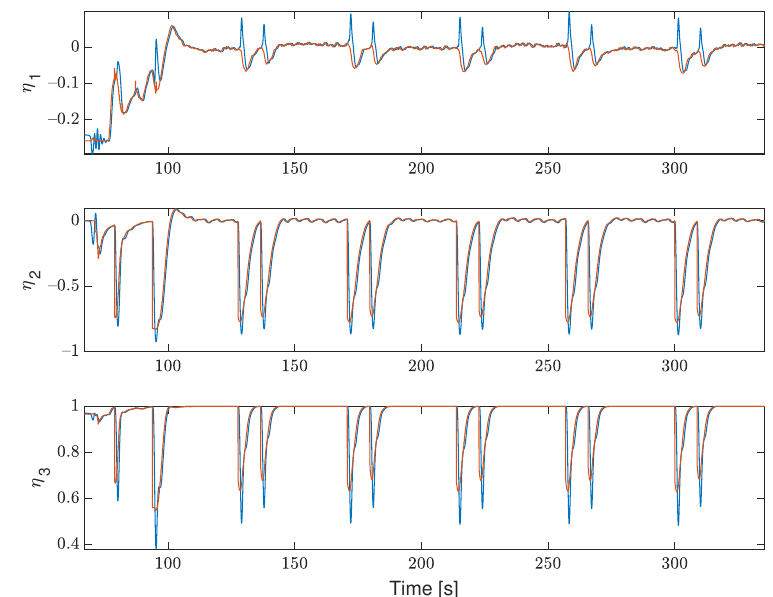
Figure 13. SITL: Reduced-attitude vector η (red) vs. reference attitude (blue).